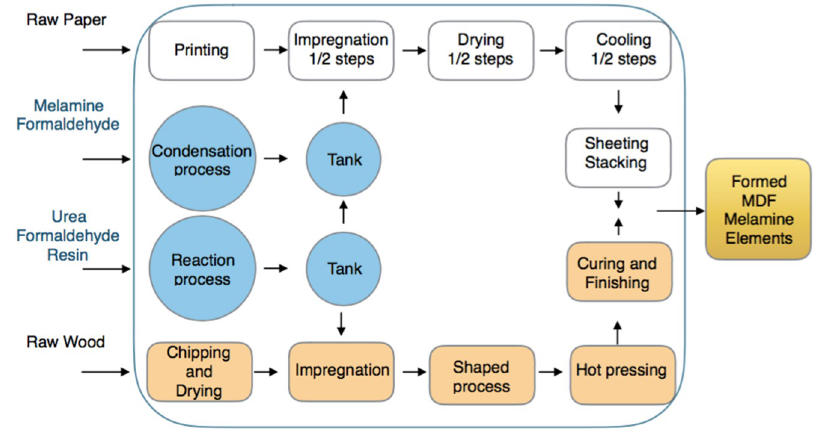
Figure 11. General production scheme of a medium-density fiberboard (MDF) urea-melamine plant.